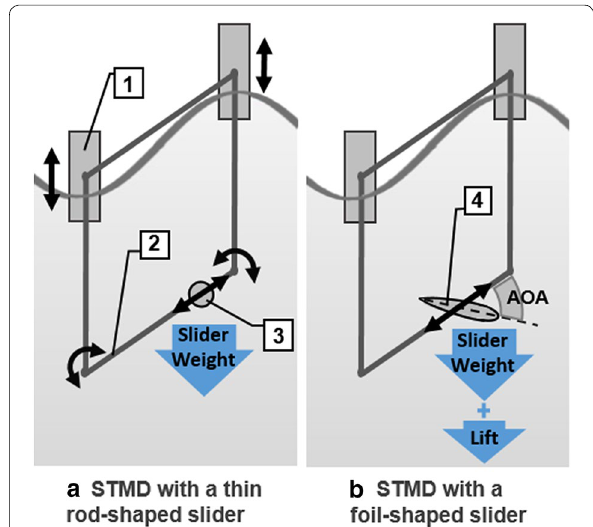
Fig. 2 Mechanism of the proposed structure. (a.1) Surface waves cause a heave motion in floaters, (a.2) The underwater frame swings due to the parallel mechanism, (a.3) The slider moves along the frame with a phase difference and its weight results a suppression force, (b.4) Changing the shape of the slider to a foil, rises lift force as an additional suppression